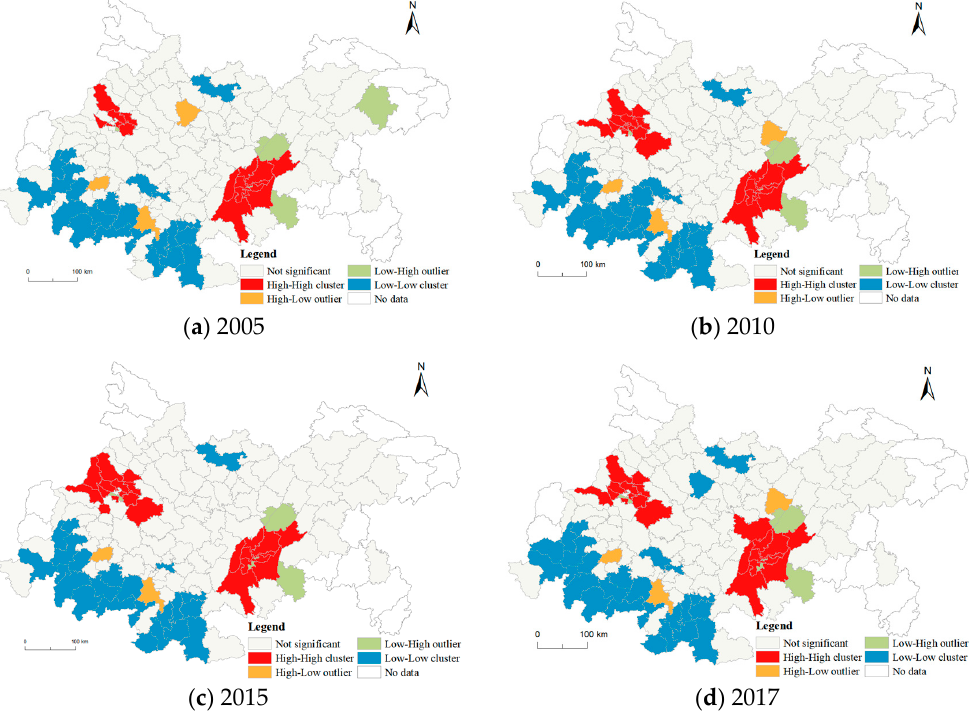
Figure 3. The LISA agglomeration map of 2005, 2010, 2015, and